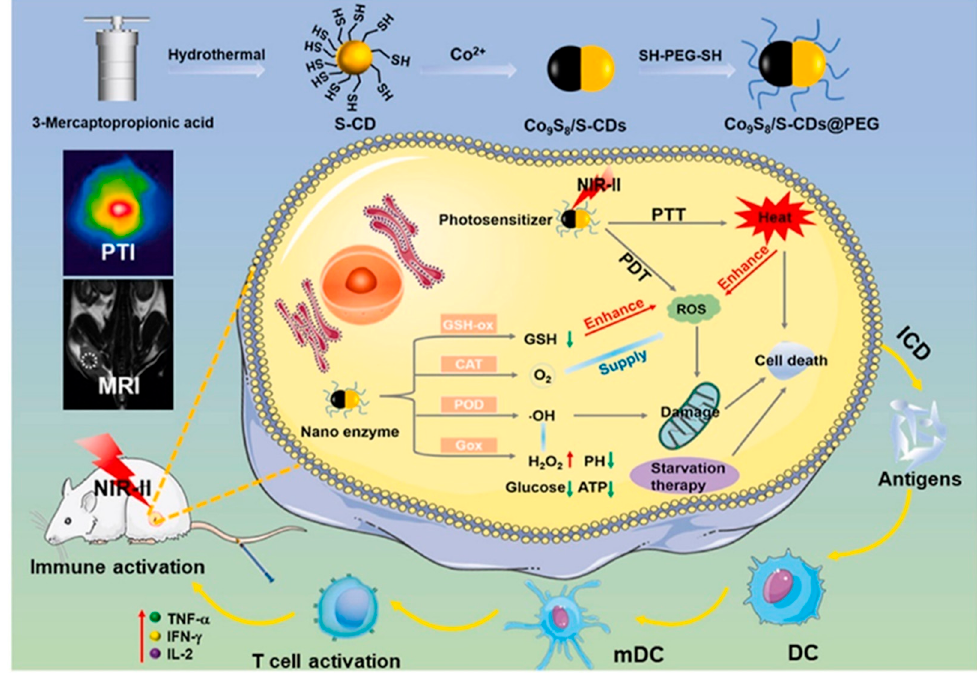
Figure 7. Schematic diagram of CSC@PEG for PTT/PDT/CDT starvation for anticancer [57]. Copy- right 2022, Elsevier.